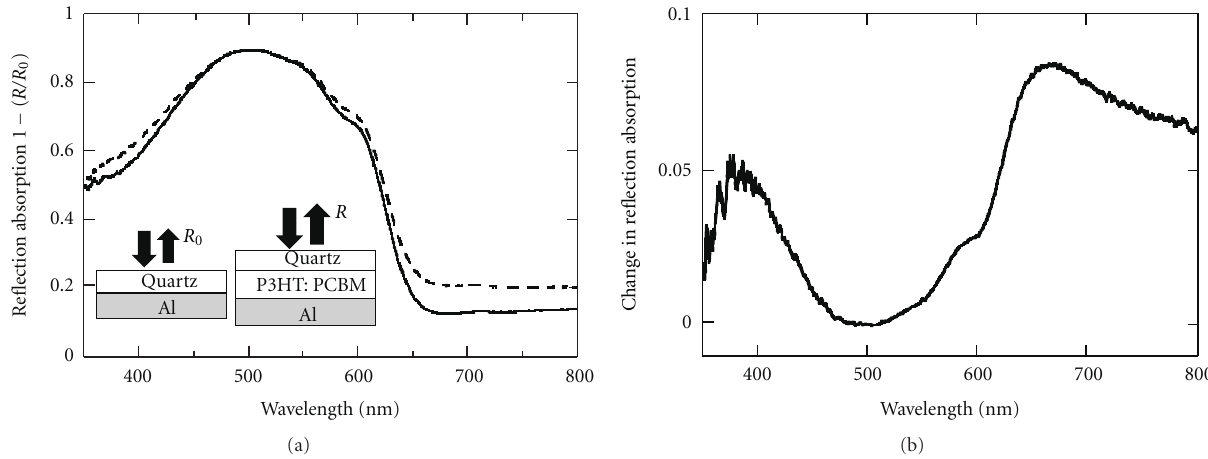
Figure 6: (a) Reflection absorption spectra for the Al electrode/P3HT :PCBM spin-coated film on quartz with and without the TiO 2 NW coating. (b) A change in reflection absorptions between with and without the NW coatings.